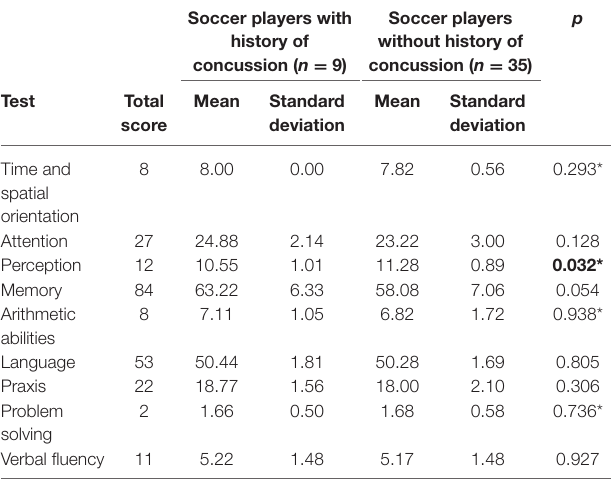
TABLE 9 | Comparison between soccer players with and without history of concussion on Neupsilin battery. Soccer players Soccer players with without history history of concussion ( n = 9)